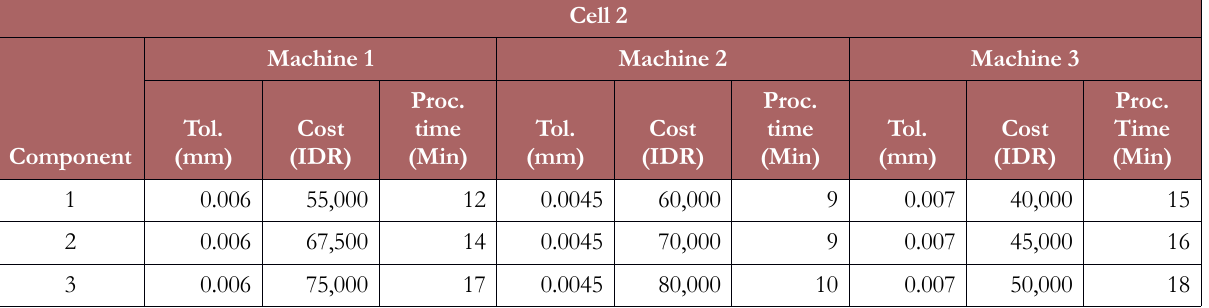
Table 2. Machine characteristics in Cell 2